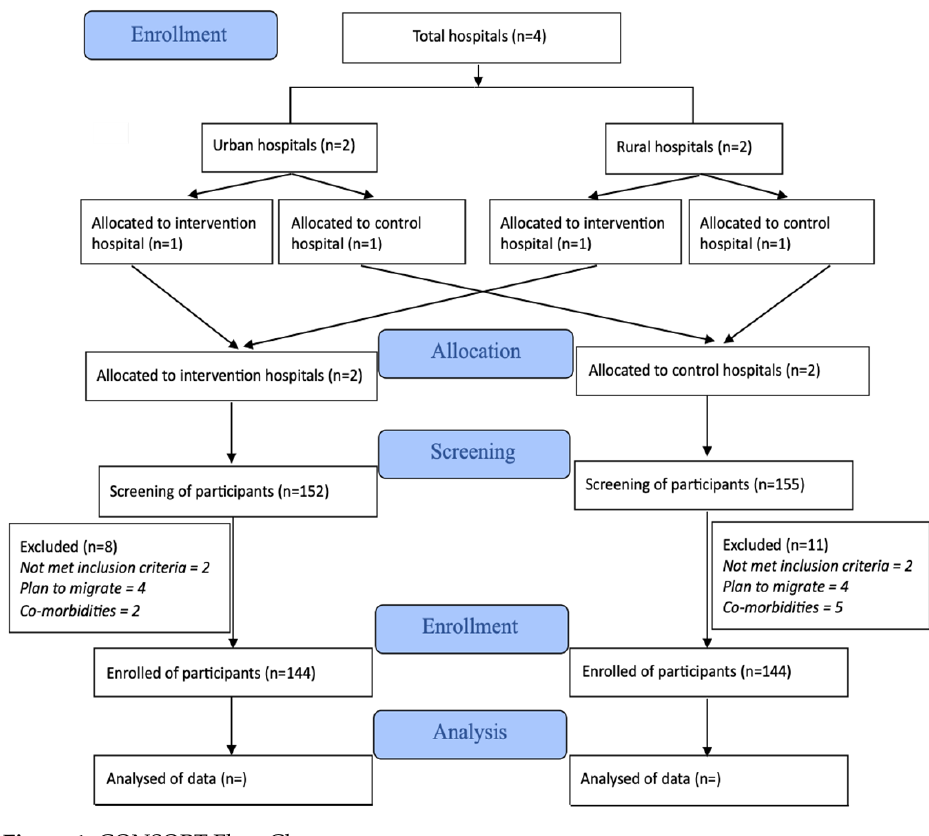
Figure 1. CONSORT Flow Chart.